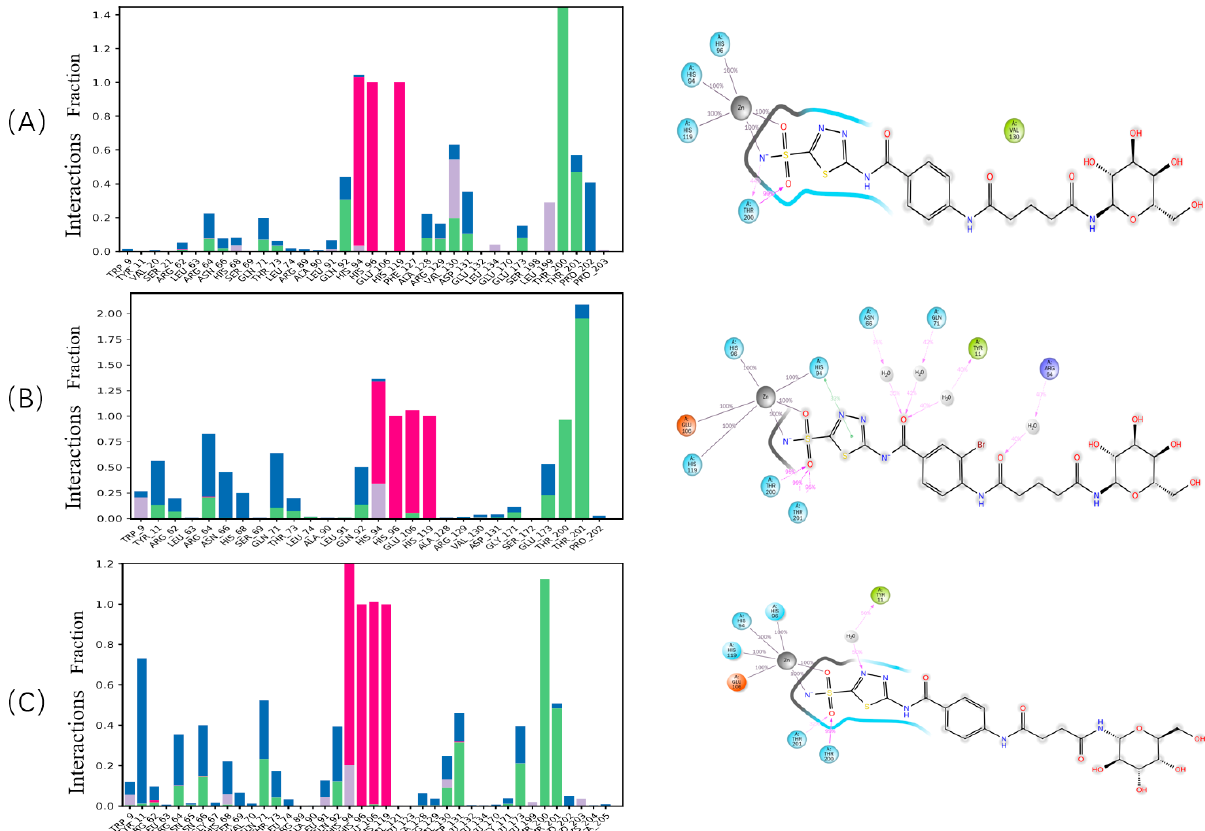
Figure 4. Protein ‐ ligand contacts during the whole MD simulations. ( A ) Interaction fraction of CA IX ‐ compound 14a complex. ( B ) Interaction fraction of CA IX ‐ compound 14e complex. ( C ) Interaction fraction of CA IX ‐ compound 14i complex.